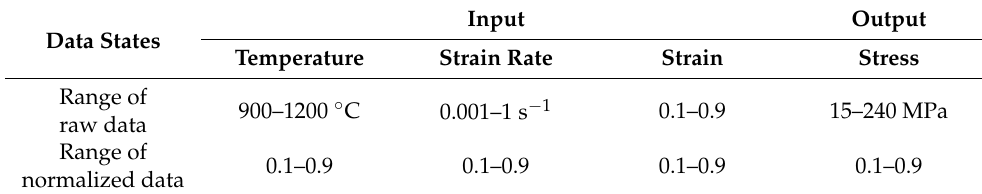
Figure 1. Architecture of the ANN used to predict the flow stress curves. Table 3. Summary of normalized input and output